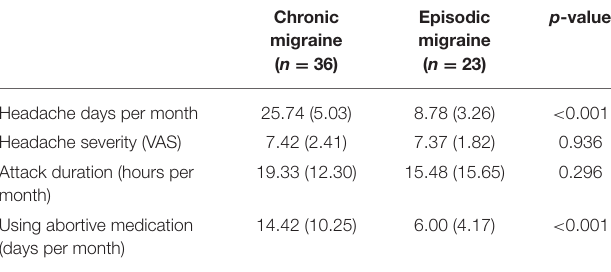
TABLE 2 | Comparison of headache characteristics between chronic and EM groups [data are shown as means